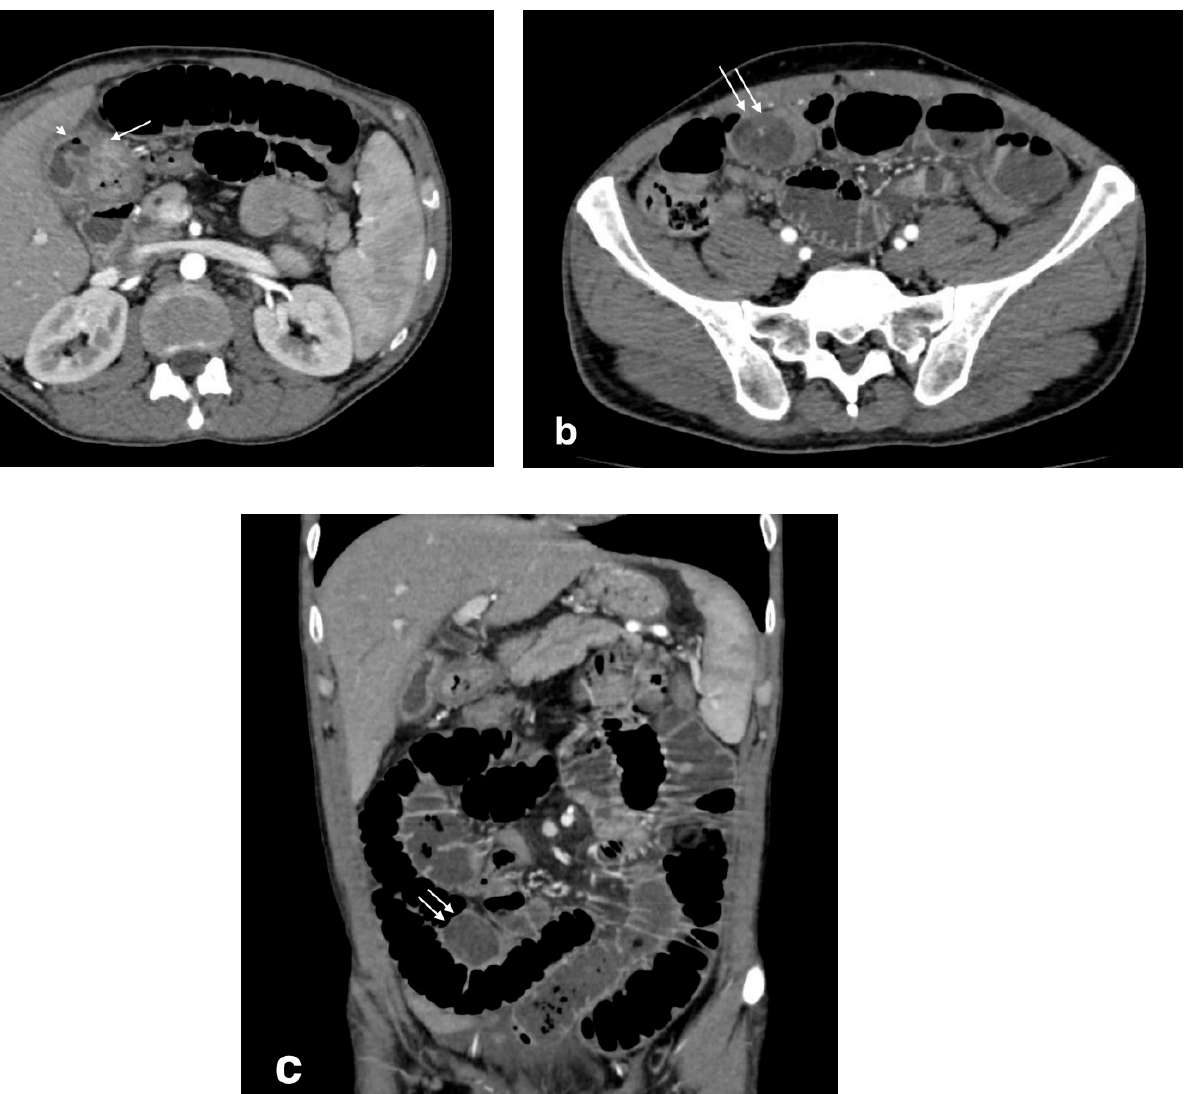
Figure 6. Bilioenteric fistula (biliogastric) with gallstone ileus: ( a ): cholecystogastric fistula (arrow)